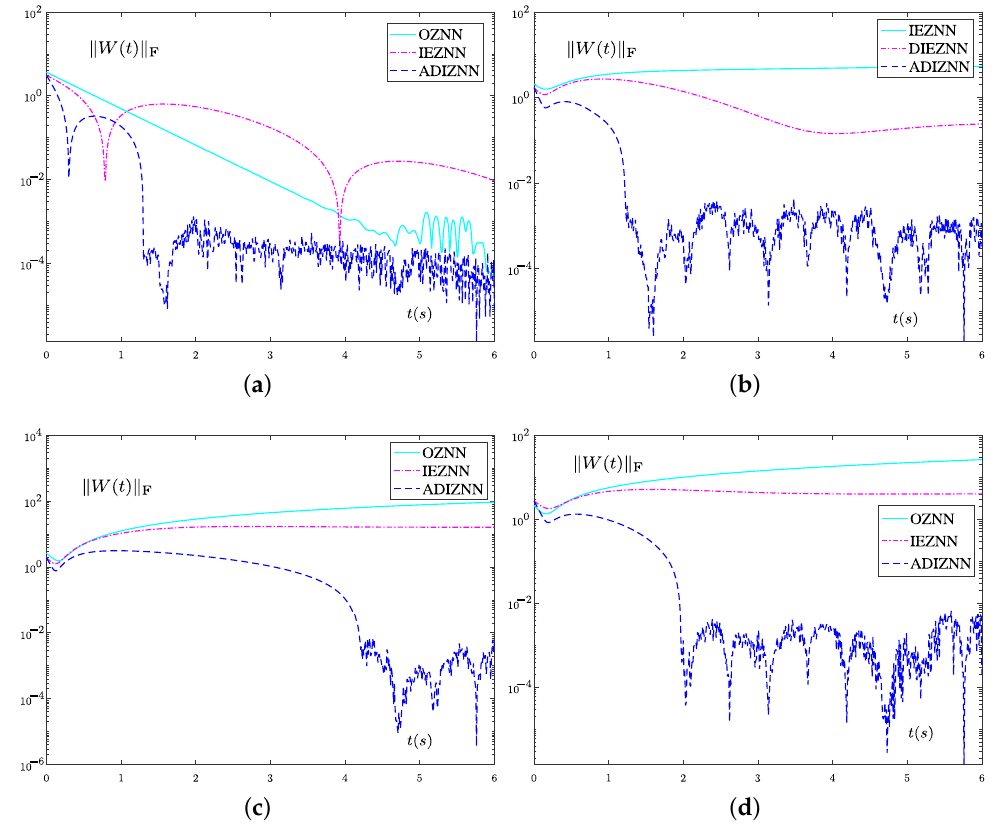
Figure 3. Error norms (cid:107) W ( t ) (cid:107) of OZNN (9), IEZNN (12) and ADIZNN (19) for the DSE with (35) in F different noise environments. ( a ) No noise z i ( t ) = 0. ( b ) Linear noise z i ( t ) = t /4 + 4. ( c ) Linear noise